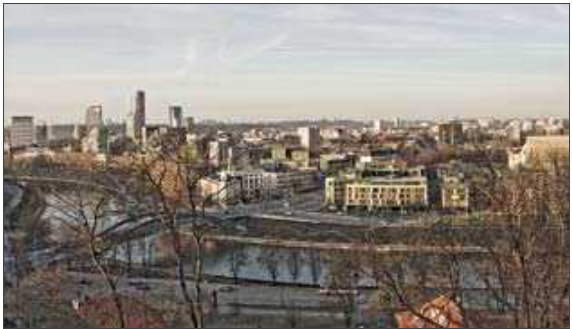
Fig. 8. View from Gediminas hill, 2008